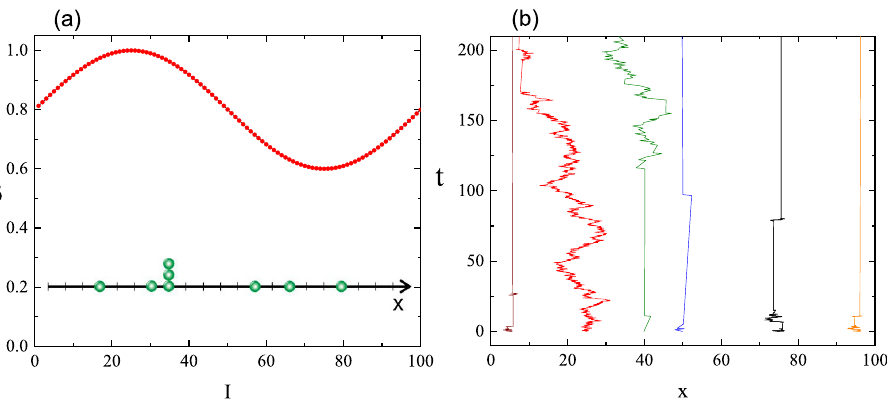
Figure 29. CTRW model in 1D. ( a ) Spatial modulation of parameter β . Inset: independent walkers on a line. ( b ) Exemplary trajectories of walkers, α =